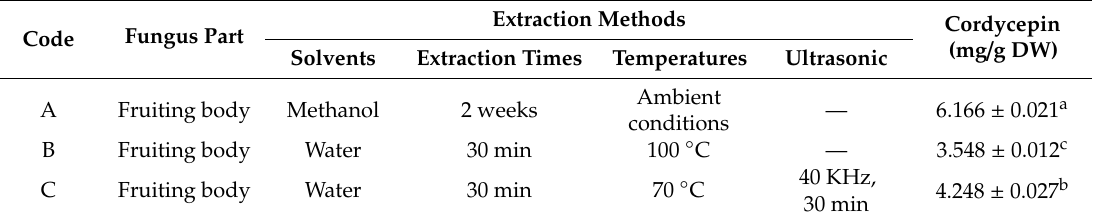
Table 5. Comparison of cordycepin content in different extraction methods of C. militaris fruiting body.